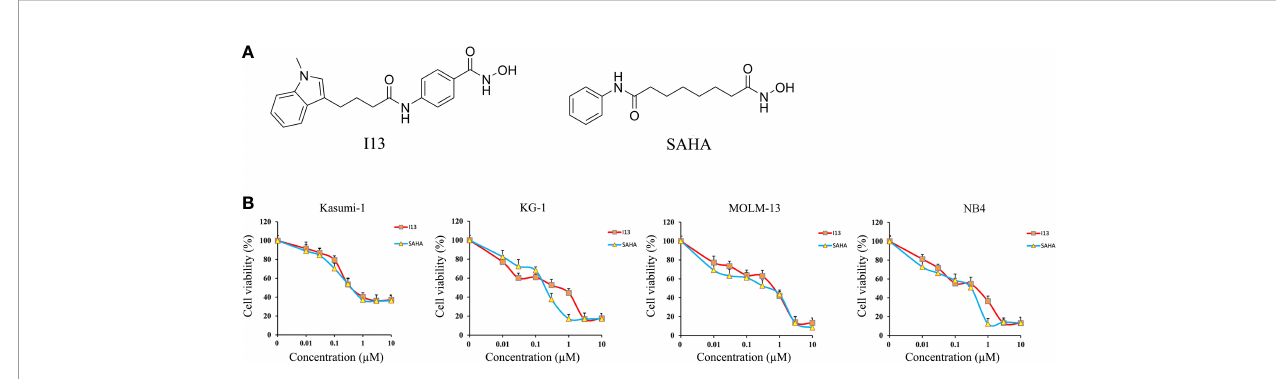
FIGURE 1 | The anti-proliferation effect of I13 on Kasumi-1, KG-1, MOLM-13 and NB4 cells. (A) The chemical structure of I13 and SAHA. (B) The effect of I13 on the proliferation of AML cells (Kasumi-1, KG-1, MOLM-13 and NB4). Cells were treated with I13 or SAHA (0.01 – 10 µM) for 72 h and then evaluated by MTT assay. The points represent the mean and error bars represent standard error from three independent triplicate